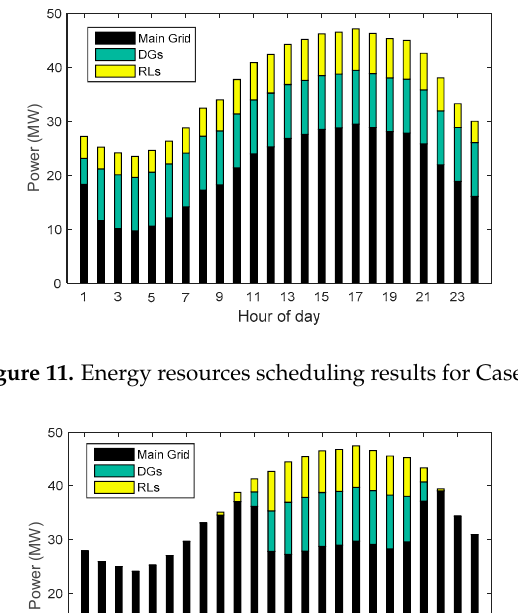
Figure 12. Energy resources scheduling results for Case 8.